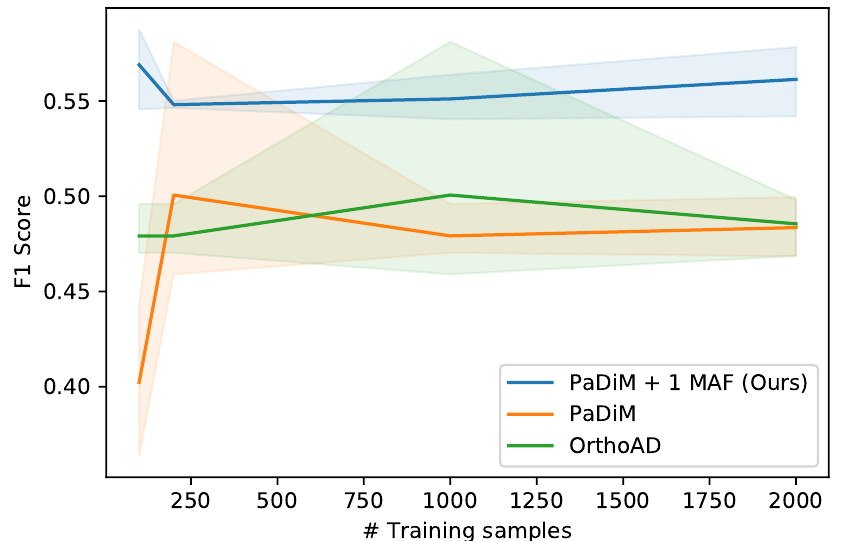
Figure 9. F1 score on the Semmacape dataset with different numbers of training samples. The mean performance and 95% confidence interval is reported over 3 runs.